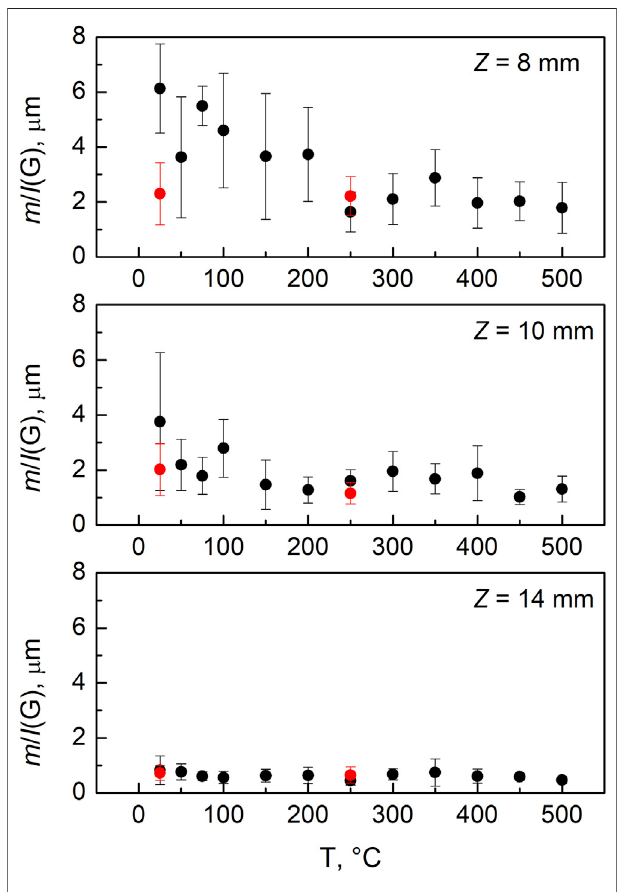
FIGURE 5 | In situ m/I(G) as a function of temperature for the three soot samples. The black dots refer to the heating stage; the red dots refer to the following cooling